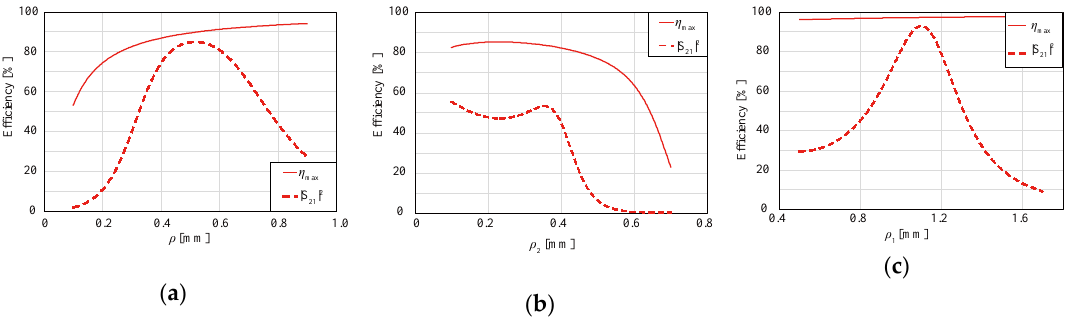
Figure 5. Wire diameter characteristic of efficiency: ( a ) spiral resonator; ( b ) folded spiral resonator with the single-layered structure; ( c ) Folded spiral resonator with double-layered structure.